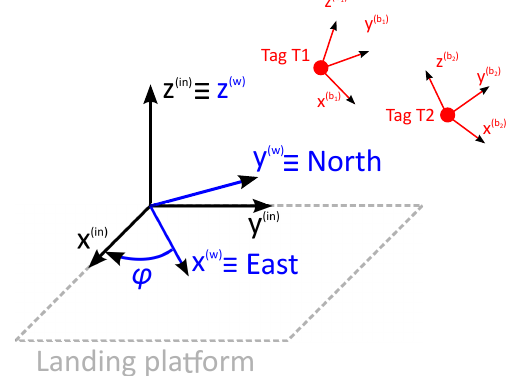
Figure 4. Flow chart of the positioning algorithm.